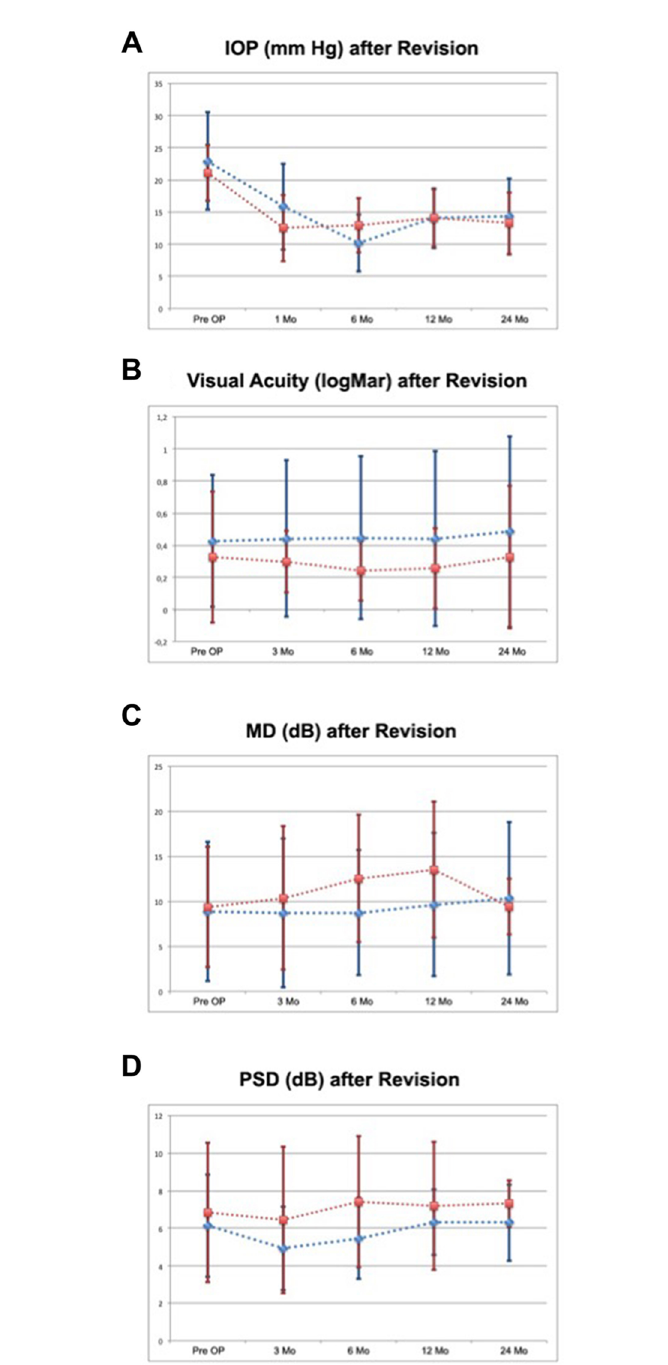
Fig 1. Courses of the intraocular pressure(A), visual acuity (B), mean deviation (C) and pattern standard deviation (D) for two yearsafter the bleb revision in both study groups. The group,